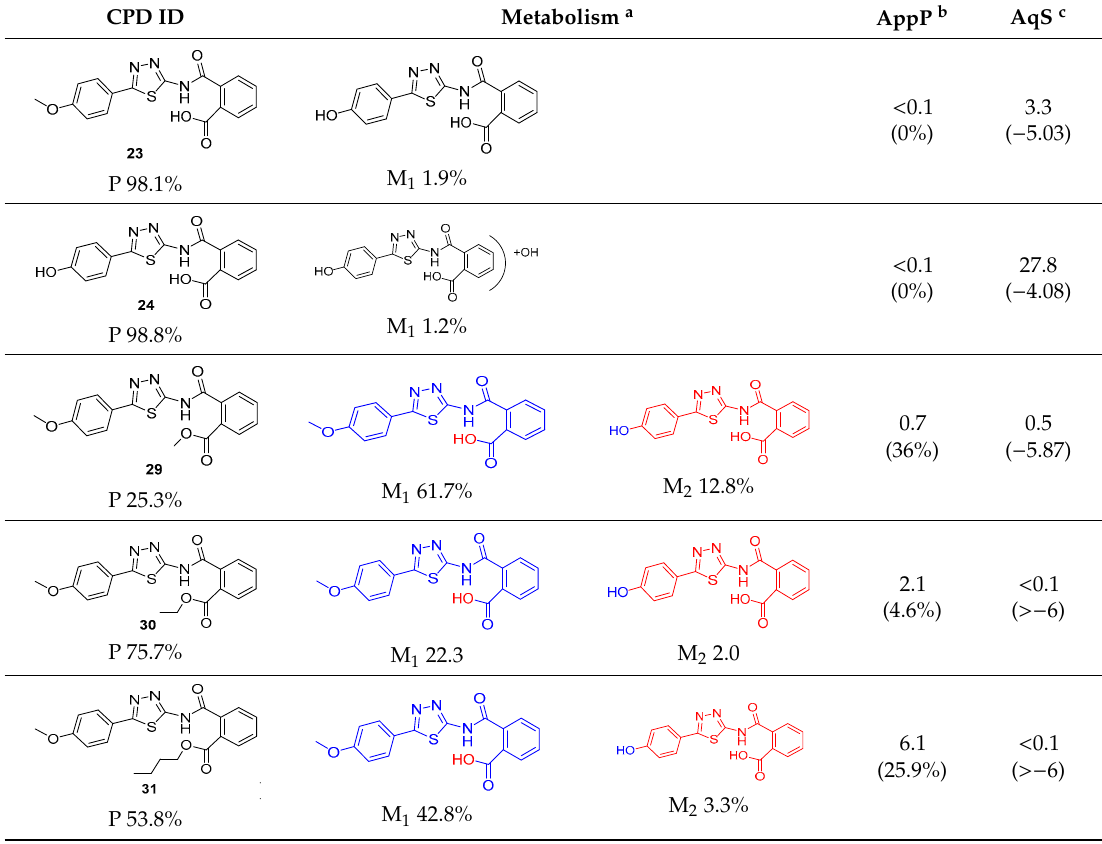
Table 2. In vitro ADME studies of selected compounds.